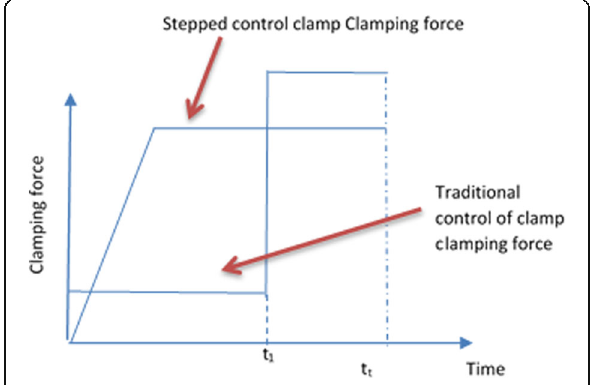
Fig. 5 Variation of blank holder force during